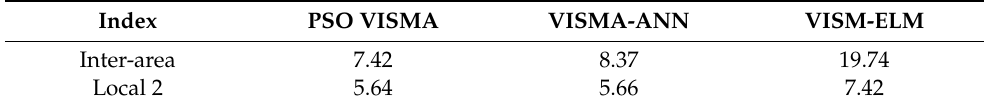
Table 9. Damping performance comparison of different methods.